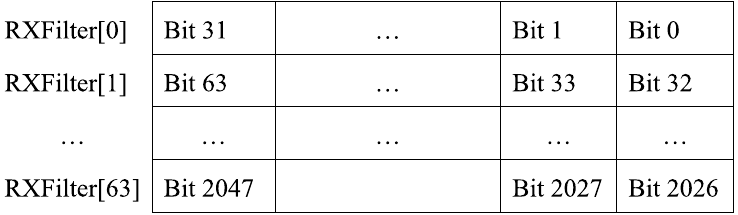
Figure 6. Structure of CAN RX message filter object.